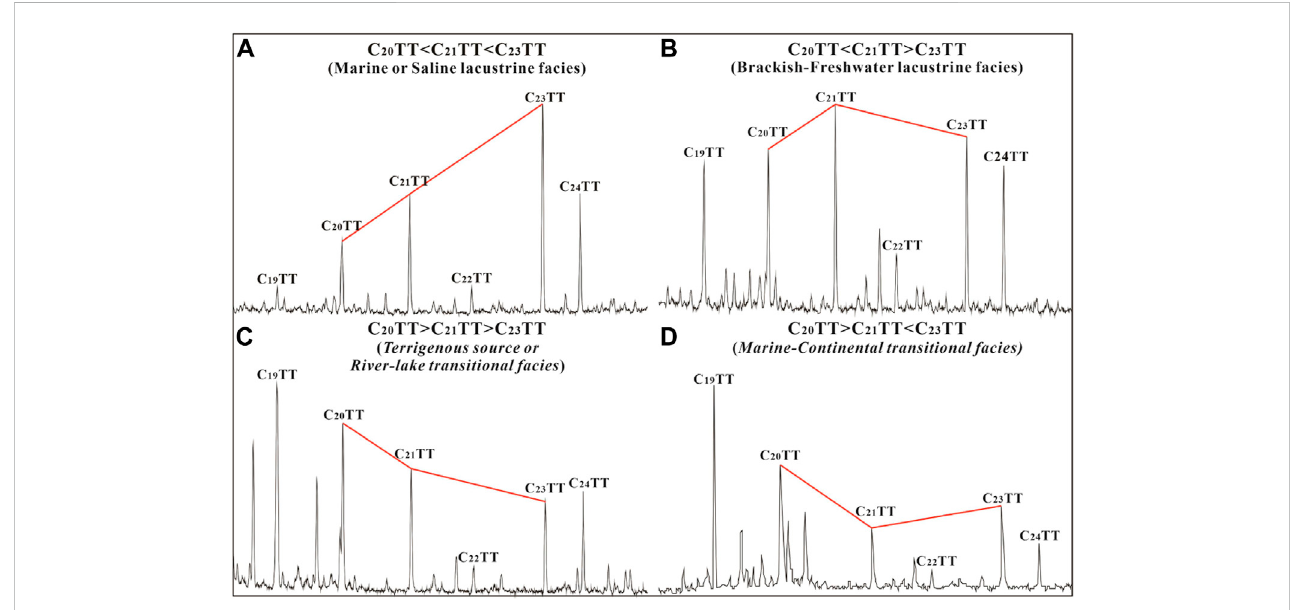
Four representative abundance patterns of C 20 -C 21 -C 23 tricyclic terpanes (TTs) in six depositional environments (A) , Marine or Saline lacustrine facies; (B) , Brackish-freshwater lacustrine facies; (C) , Terrigenous or River-lake transitional facies; (D) , Marine-continental transitional facies.